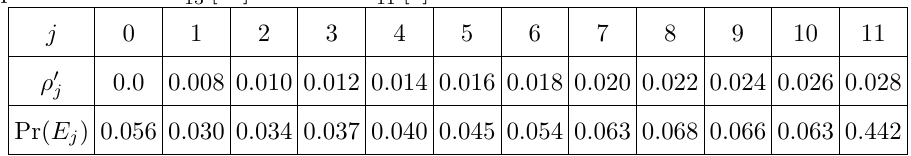
[13], OD ∆ (3) [0]. 13 11